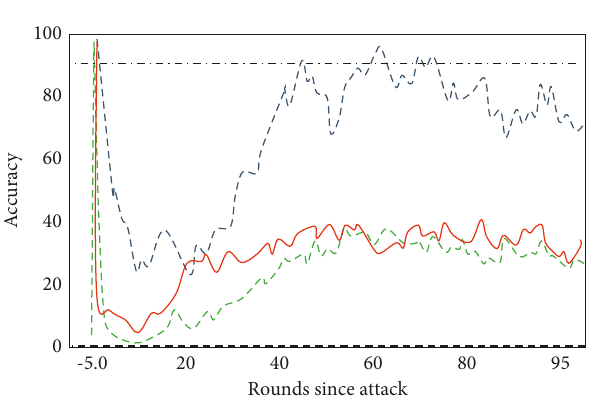
Figure 3: Accuracy